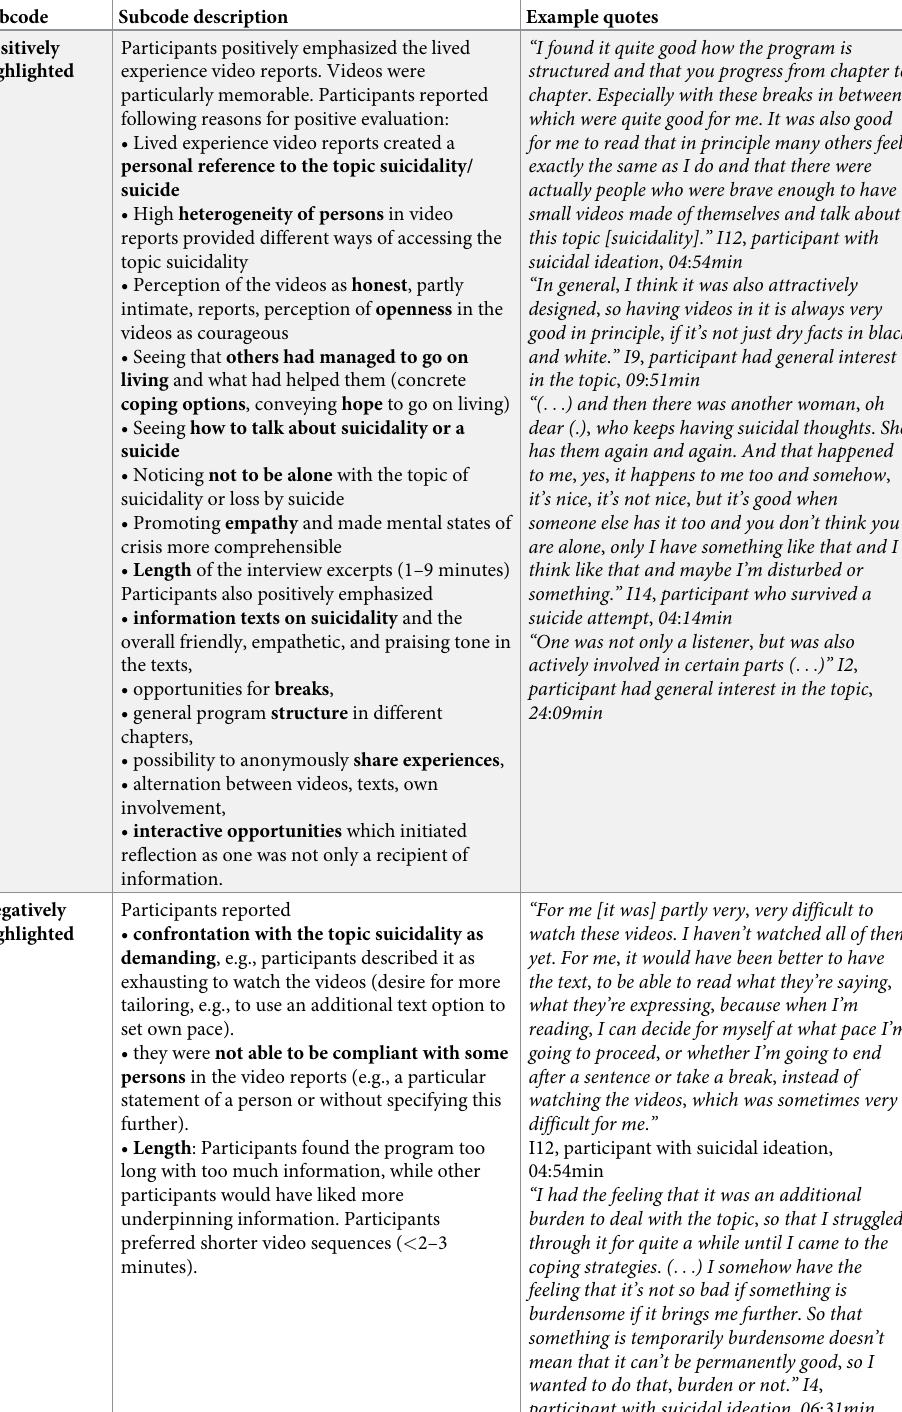
Table 5. Identified subcodes of main code “overall evaluation” and example quotes from the 16 follow-up tele- phone interviews 12–26 weeks after program